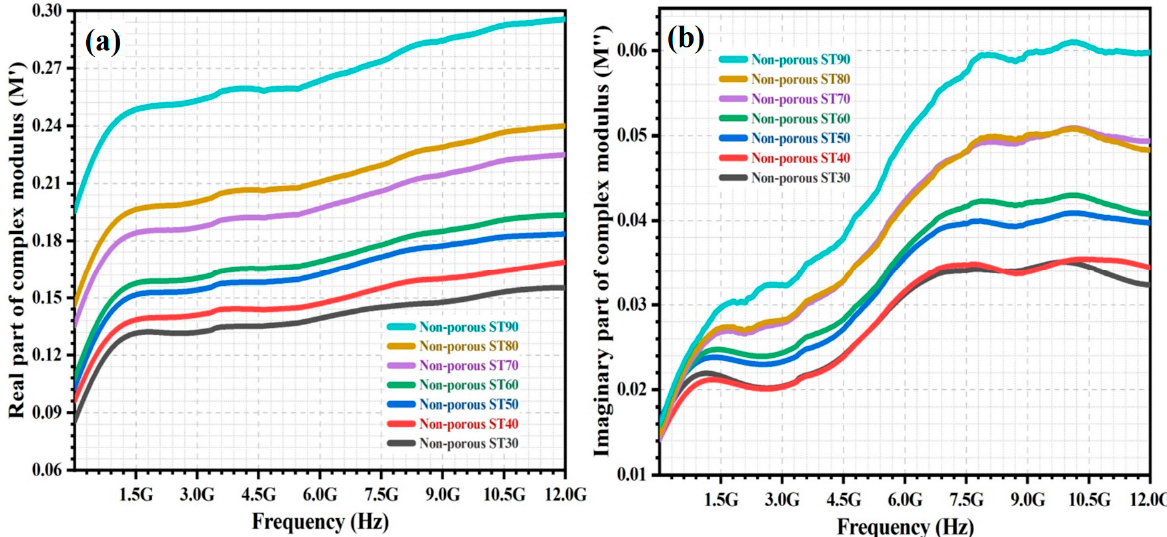
Figure 2. The variation of ( a ) M’ and ( b ) M ″ of non-porous HAp/ST composites over frequency.